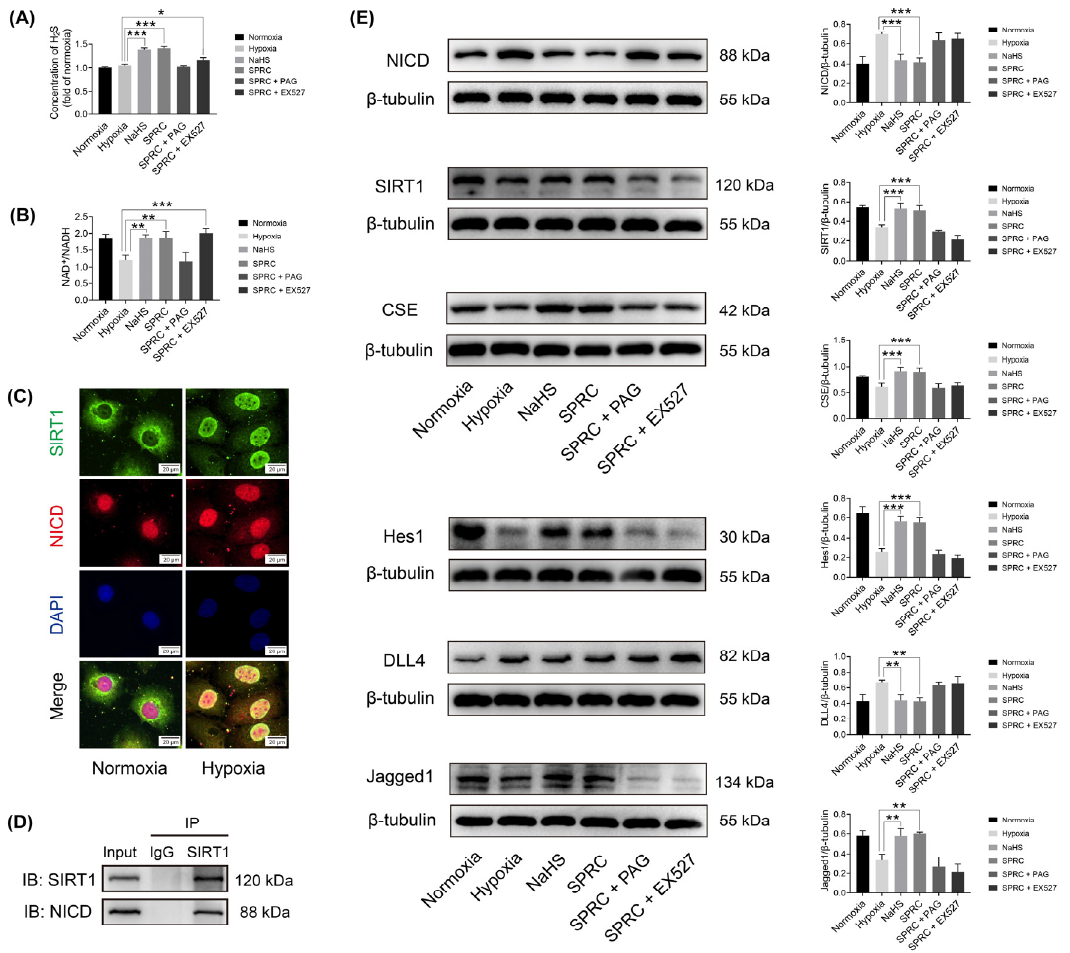
Figure 4. Hydrogen sulfide (H 2 S) level, nicotinamide adenine dinucleotide (NAD + )/NADH ratio, sirtuin1 (SIRT1) and Notch1 intracellular domain (NICD) cell localization, interaction, and cystathi- onine- γ -lyase (CSE), SIRT1, NICD, Delta-like ligand 4 (DLL4), Jagged1 and hairy and enhancer of split 1 (Hes1) protein expression assessments in HUVECs at 6 h after different treatments. ( A ) Sta- tistical analysis of intracellular H 2 S level. ( B ) Statistical analysis of intracellular NAD + /NADH ratio. ( C ) Co-localization of SIRT1 (green) and NICD (red) under normoxic or hypoxic condition. DAPI (blue) showed the nucleus. ( D ) Co-immunoprecipitation of NICD and SIRT1 under hypoxic condi- tion. IP, immunoprecipitation; IB, immunoblotting. ( E ) Western blotting (WB) analysis of CSE, SIRT1, NICD, Jagged1, DLL4 and Hes1 protein expressions. Relative grey values analyses were per- formed. β -tubulin was used as a loading control. Data were presented as mean ± SME ( n = 3 inde- pendent experiments). * p < 0.05 vs. hypoxia group, ** p < 0.01 vs. hypoxia group, *** p < 0.001 vs. hypoxia group.